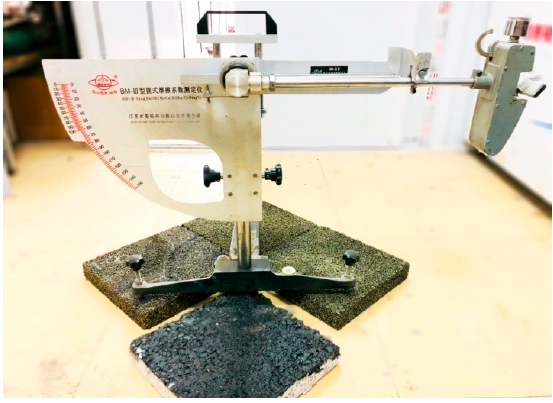
Figure 7. The test of skid resistance.